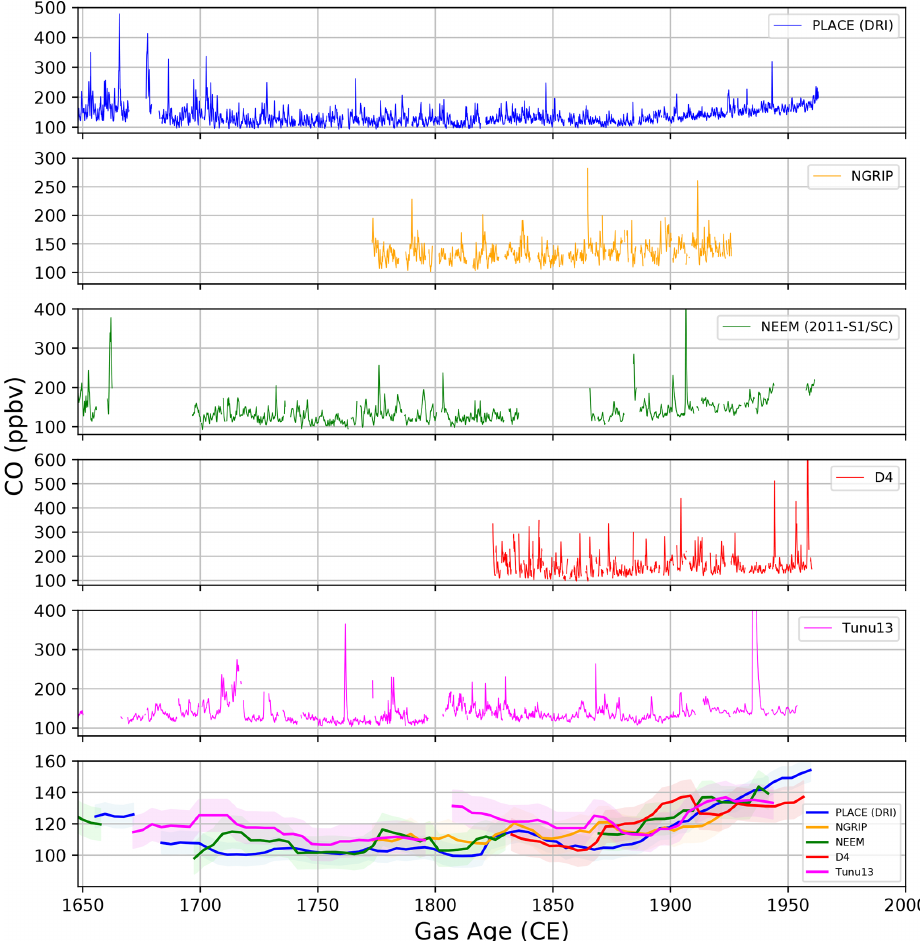
Figure 1. The first five panels (from top to bottom) show the Greenland continuous CO records available from the PLACE (DRI), NGRIP, NEEM, D4, and Tunu13 ice cores, respectively, and are plotted for the period spanning from 1650 to 1960CE. The bottom panel shows the CO baseline levels from each ice record, defined as the 5th percentile of data every 4 years over a 15-year moving window, with the shaded regions on each baseline representing the